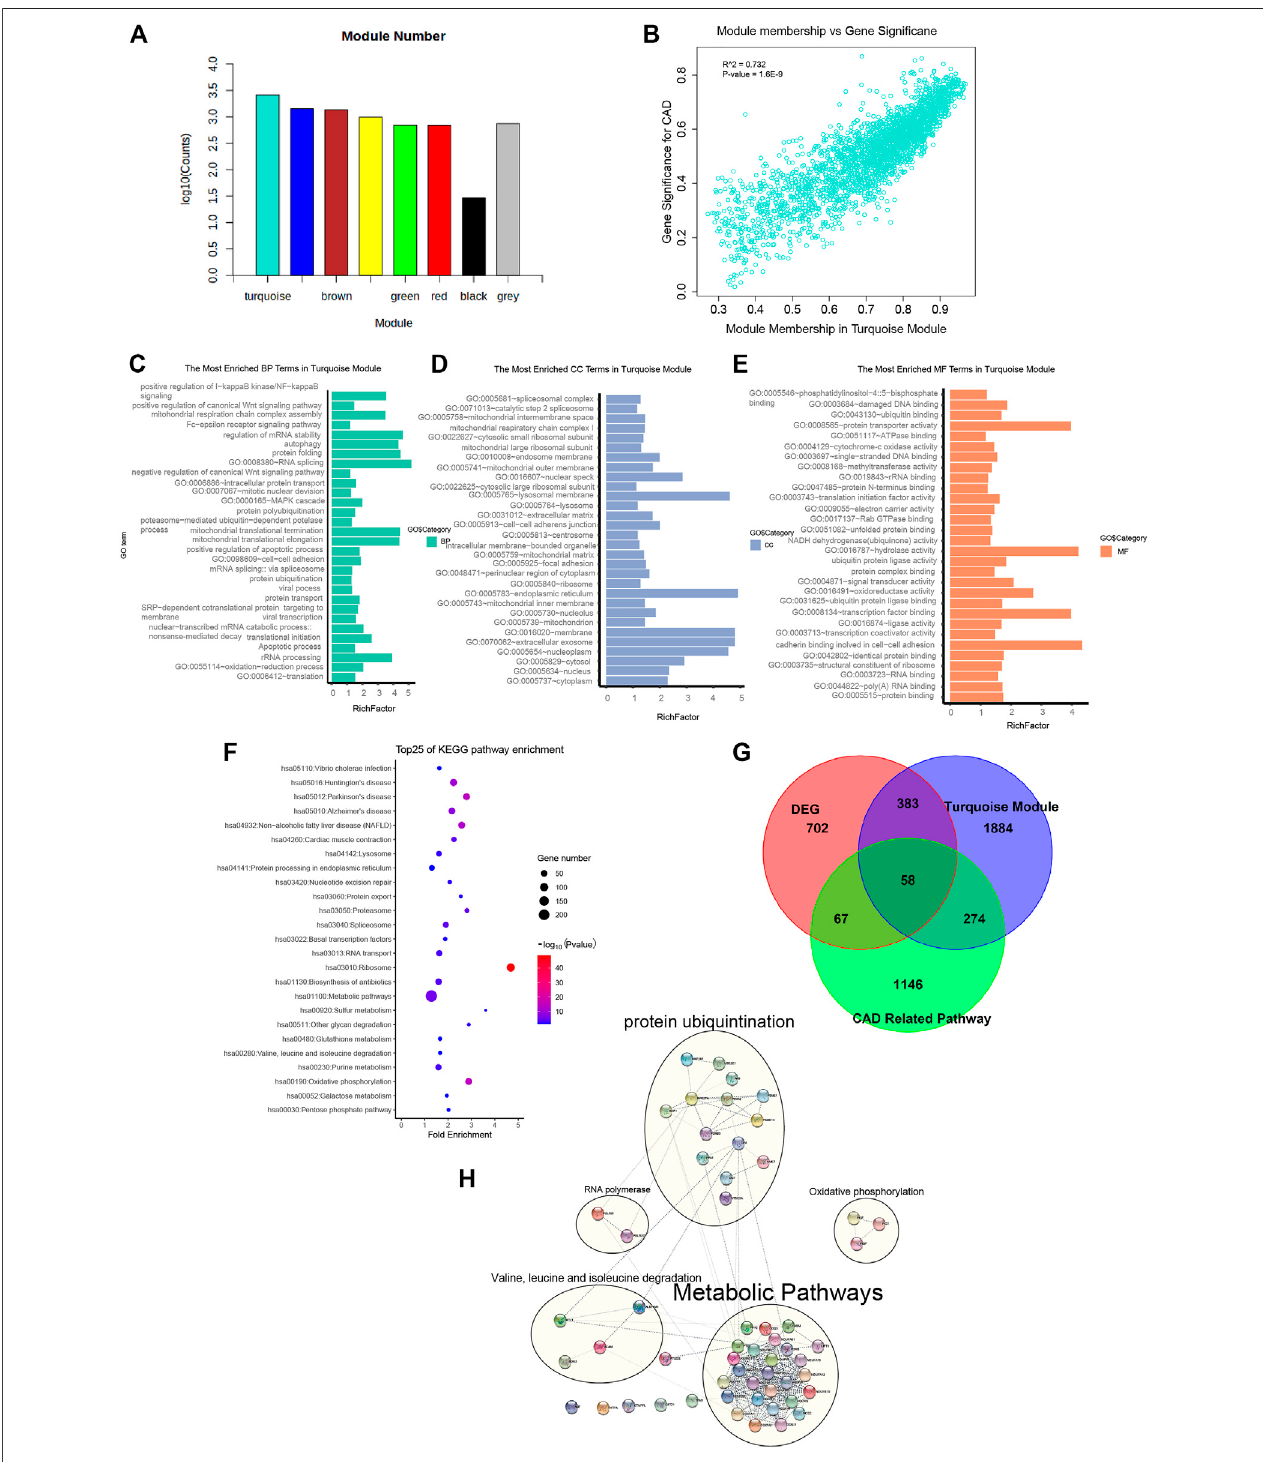
FIGURE 2 | Genes from the turquoise module mainly enriched in metabolic pathways, oxidative phosphorylation, cardiac muscle contraction, and protein ubiquitination. (A) Gene numbers in all modules. Detailed gene symbols are listed in Supplementary Table S1 . (B) Scatter plot showing the gene signi fi cance for coronary artery disease (CAD) versus module membership in the turquoise module (correlation coef fi cient = 0.732, p = 1.6e − 9). (C – E) Histogram showing the Gene Ontology (GO) enrichment analysis for the genes in the turquoise module. The terms enriched in the category of molecular function (MF), biological process (BP), and cellular component (CC) are presented. The corresponding terms and adjusted p -values in each category are listed in Supplementary Table S1 . (F) Bubble chart